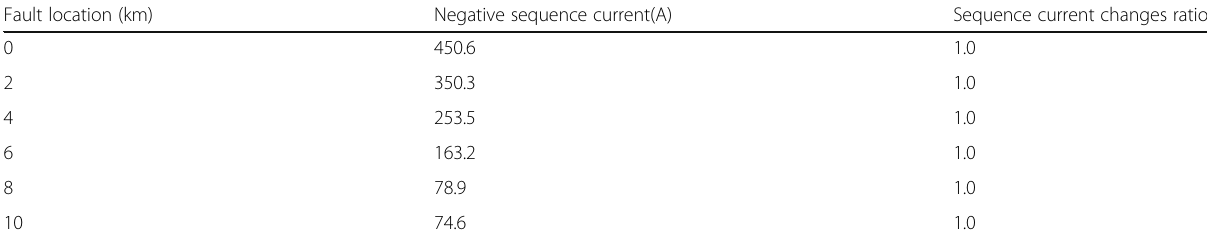
Table 5 Comparison of the line selection criterias Fault location (km)